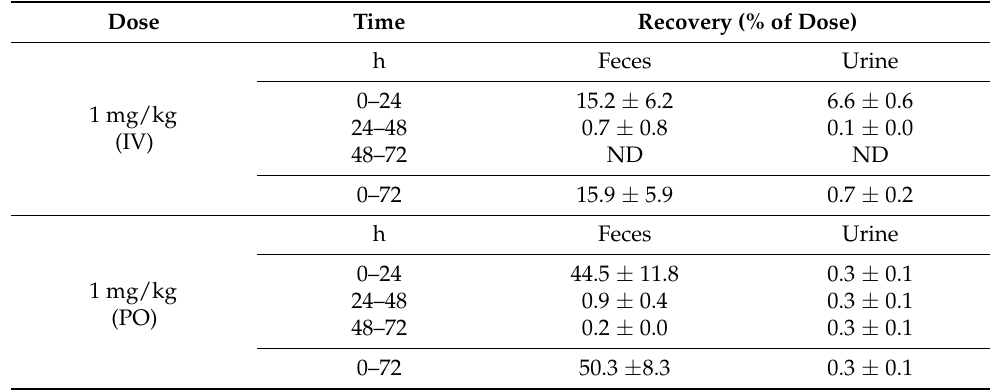
Table 5. Recovery of enavogliflozin for 72 h in